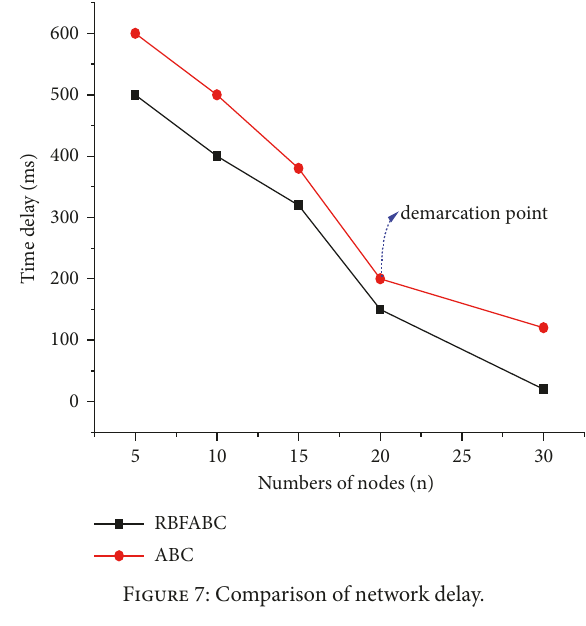
Figure 5: The relationship between iteration number and optimal solution.